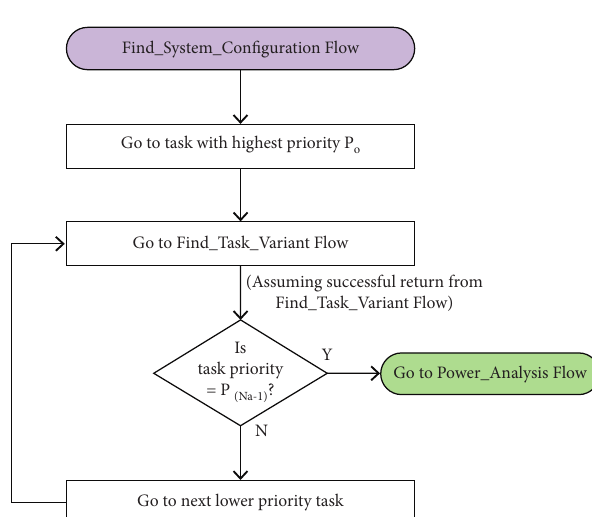
Figure 5: Find_Task_Variant flow of